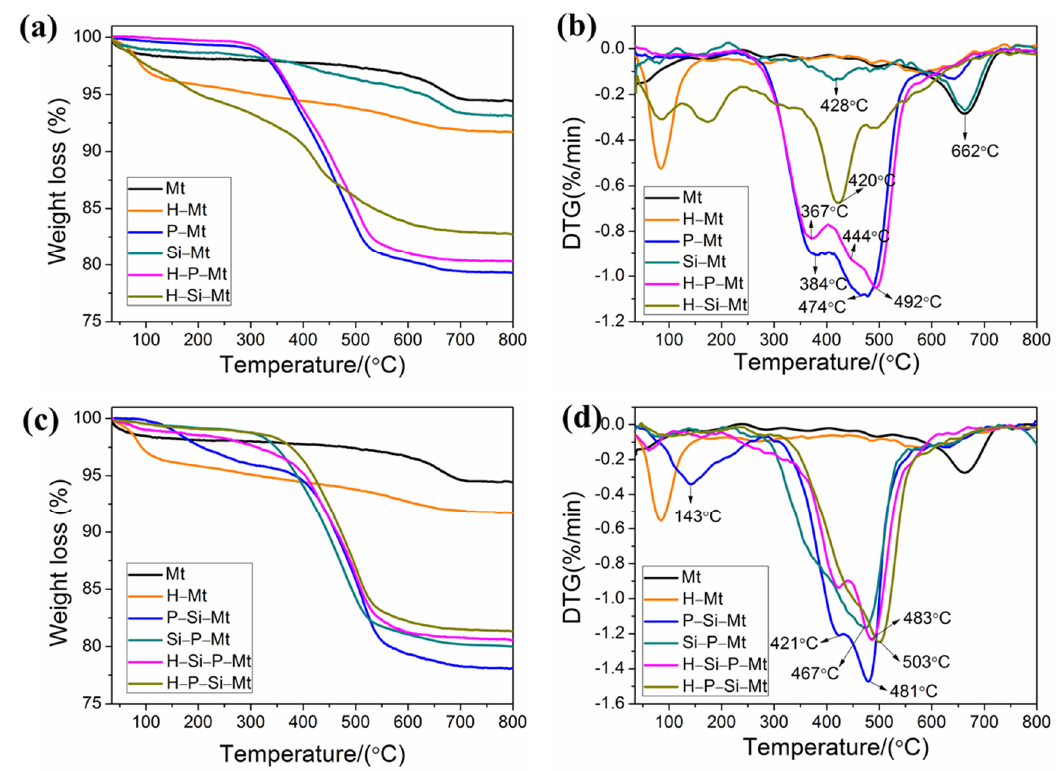
Figure 6. ( a , c ) TGA and ( b , d ) DTG curves of Mt and functionalized Mt samples. For the H-P-Mt, the mass loss of physisorbed water was only 0.2 wt.%, compared with 1.9 wt.% for Mt and 4.2 wt.% for H-Mt, indicating that the H-Mt that was intercalated with